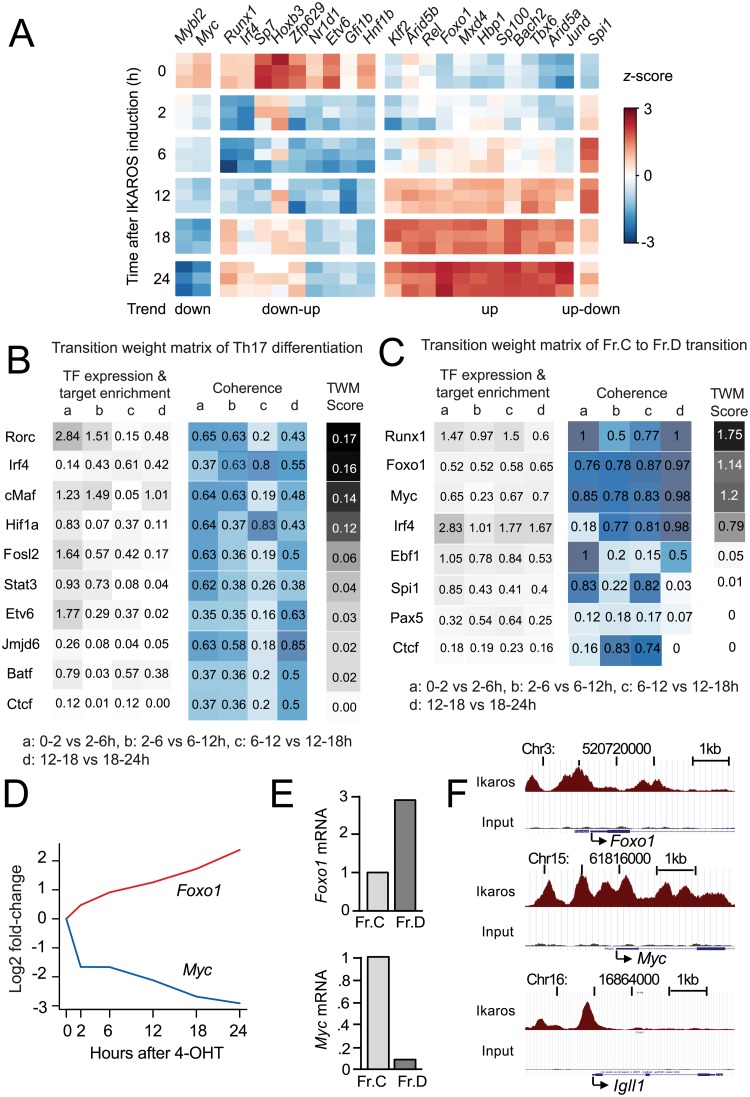
Systematic identification of candidate regulators of B cell progenitor differentiation.(A) Heat map of 23 candidate transcriptional regulators of B cell progenitor differentiation identified by 3 RNA-seq replicates at the indicated time after Ikaros induction in B3 cells; expression trends are indicated. The source of the numerical data underlying this figure is listed in S1 Data. (B) TWM analysis of Th17 differentiation. See text and S3 Fig for details and “Methods” for a comprehensive mathematical description. (C) TWM analysis of the Fr.C to Fr.D transition based on target genes defined by ChIP-seq identified RUNX1, FOXO1, and Myc as high-scoring regulators. (D) Progressive up-regulation of Foxo1 mRNA and down-regulation of Myc mRNA with time after Ikaros induction. Shown is the mean of 3 independent RNA-seq replicates. (E) Up-regulation of Foxo1 mRNA during in vivo B cell progenitor differentiation ([5]; www.immgen.org). Down-regulation of Myc mRNA during in vivo B cell progenitor differentiation ([5]; www.immgen.org). (F) Ikaros ChIP-seq [7] shows Ikaros binding to the promoter regions of Foxo1 and Myc. The established Ikaros target gene Igll1 is shown for reference. ChIP-seq, chromatin immunoprecipitation sequencing; FOXO1, Forkhead Box O1; Fr.C, proliferating B cell progenitor; Fr.D, differentiating B cell progenitor; Myc, MYC proto-oncogene; RNA-seq, RNA sequencing; RUNX1, RUNT-related transcription factor; Th17, T helper 17; TWM, transition weight matrix.